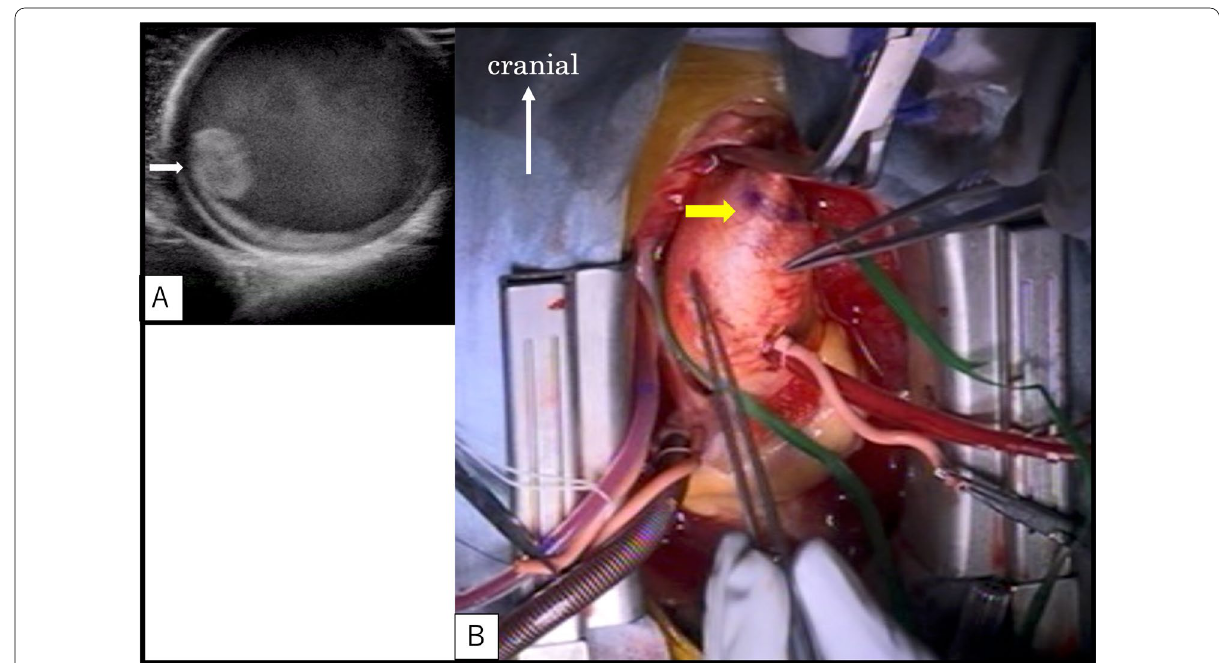
Fig. 2 Epiaortic echography confirms the location of the thrombus (white arrow) in the ascending aorta ( A ). We marked the position on the most cephalad side of the floating thrombus (yellow arrow) and determined the locations for aortic cross-clamping and aortotomy ( B